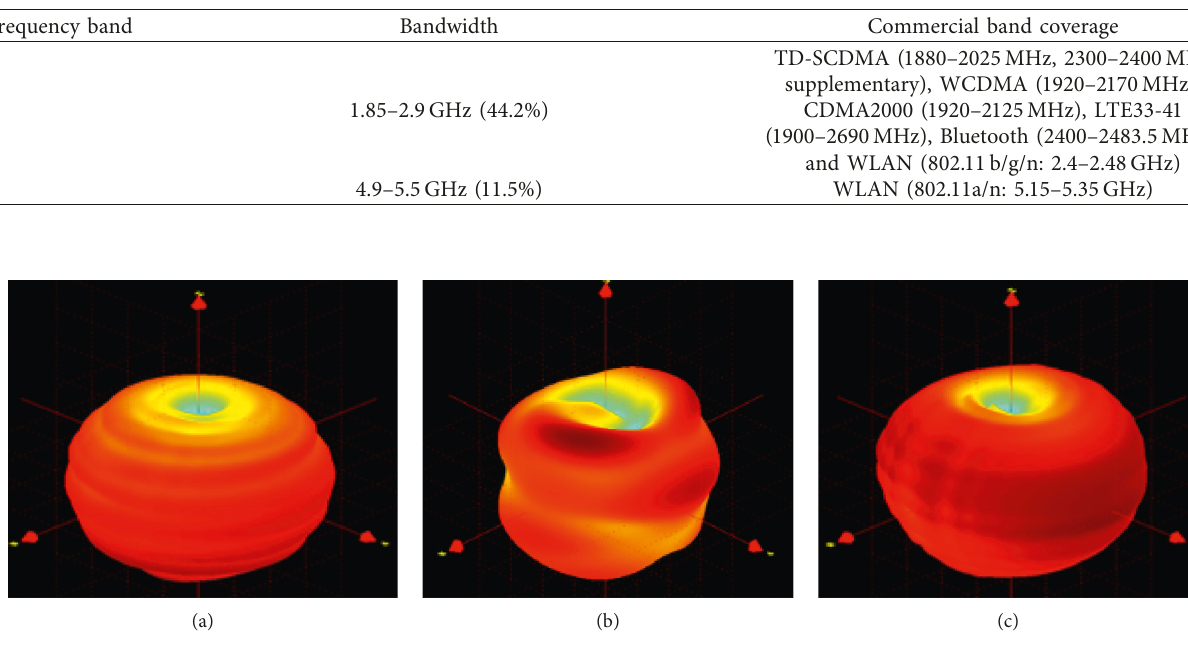
Figure 11: Measured 3D radiation patterns. (a) 2GHz. (b) 3.25GHz. (c)